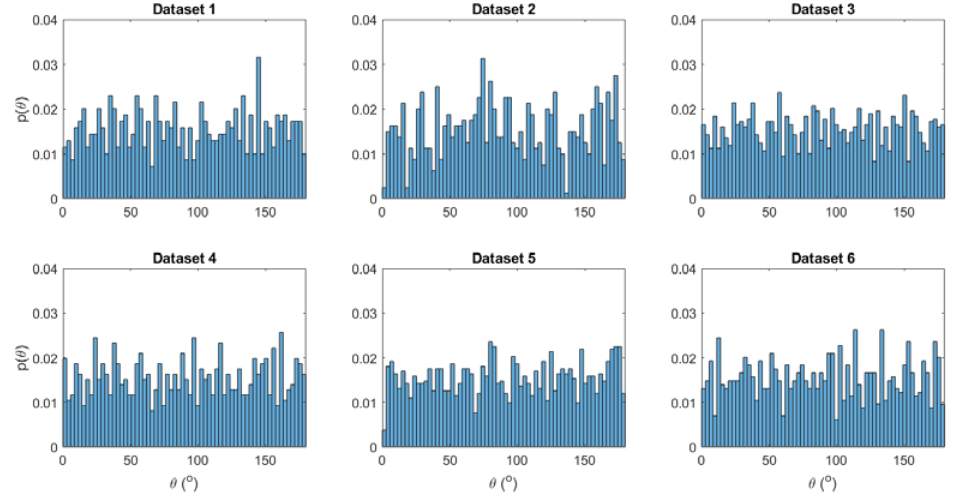
Figure 3. Histograms of horizontal direction observations from six real TLS self-calibration